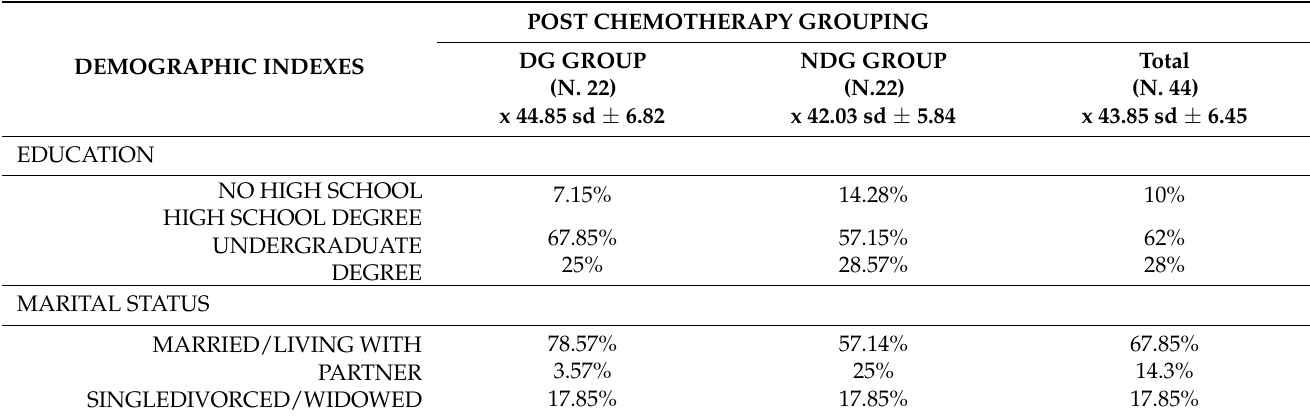
Table 1. Demographic and clinical data of the